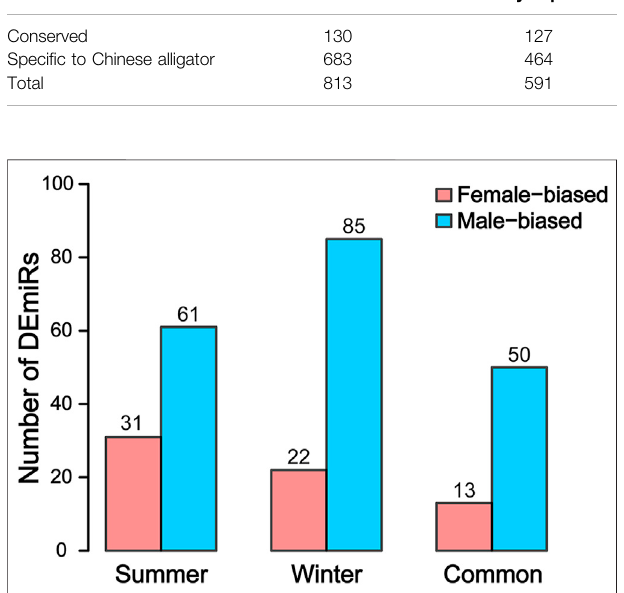
FIGURE 2 | Female- and male-biased differentially expressed miRNAs (DEmiRs) in adult Chinese alligator gonads sampled in summer and